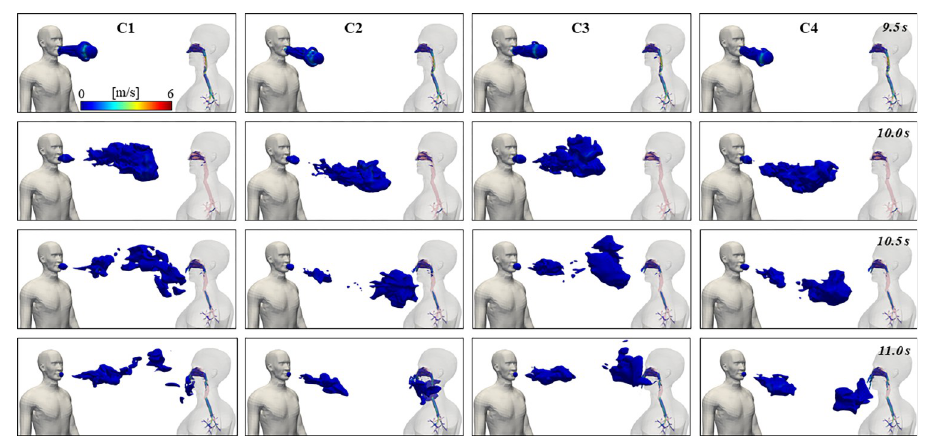
Fig 5. 3D depiction of speech jet generated by Human 1 over one cycle and inhaled/exhaled air by Human 2 for all